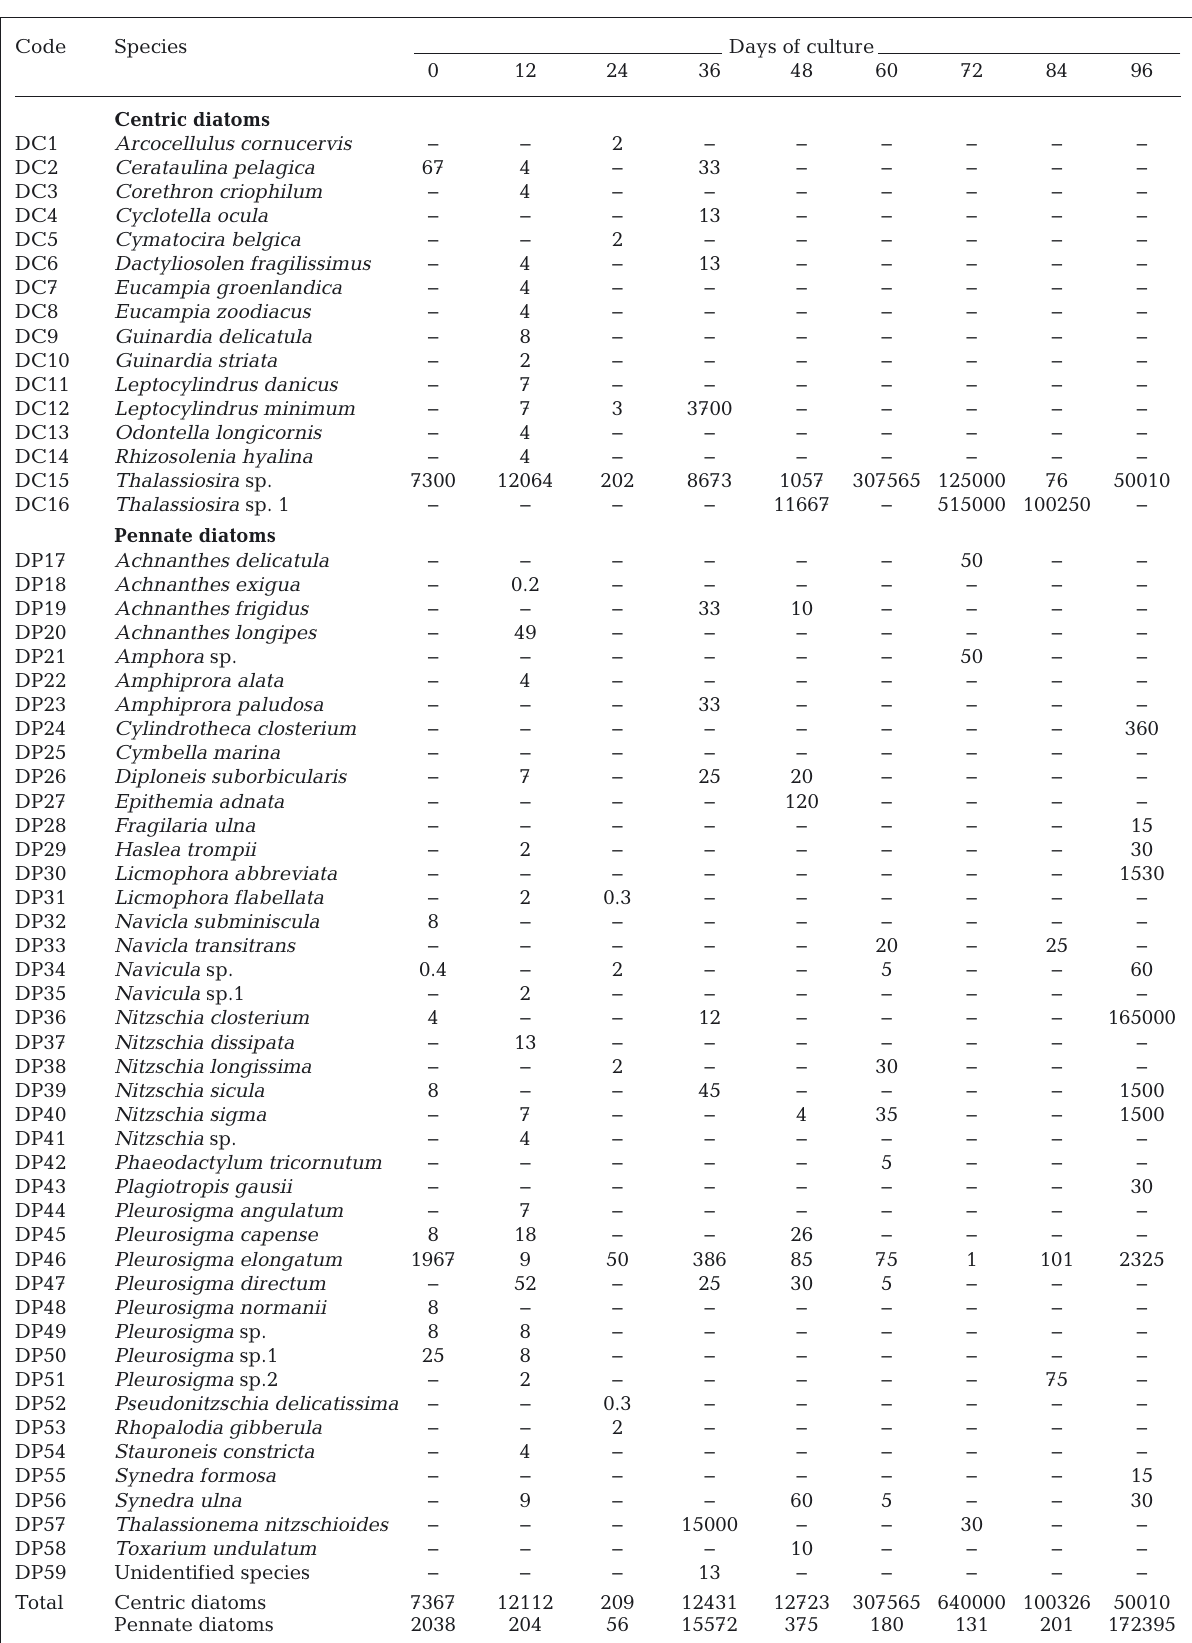
Table 2. Temporal variation in abundance (cells l −1 ) of phytoplankton communities during the culture of